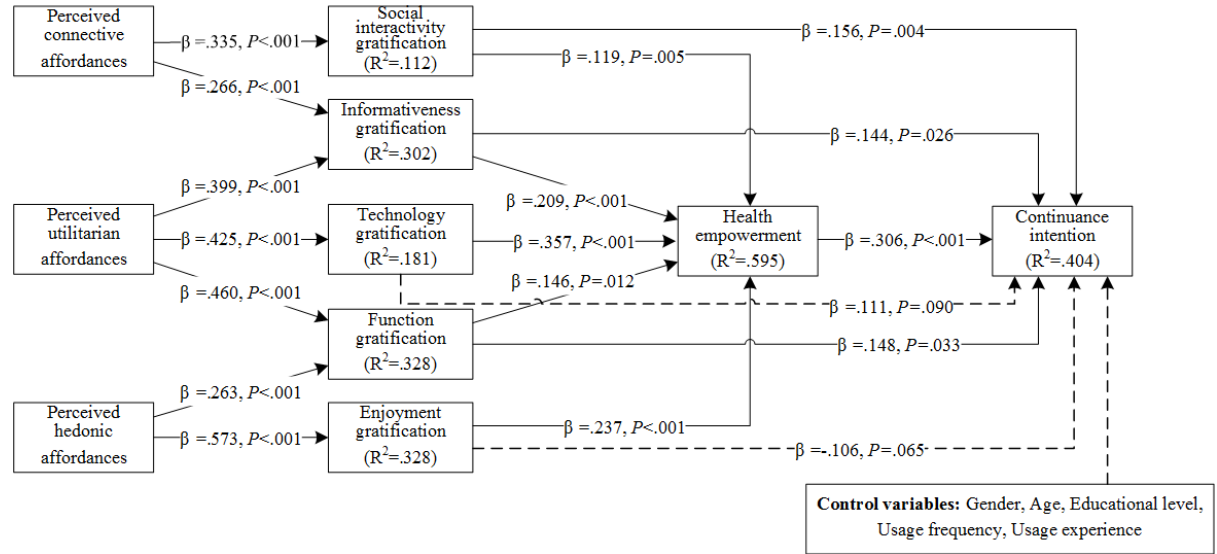
Figure 2. Analysis results of the structural